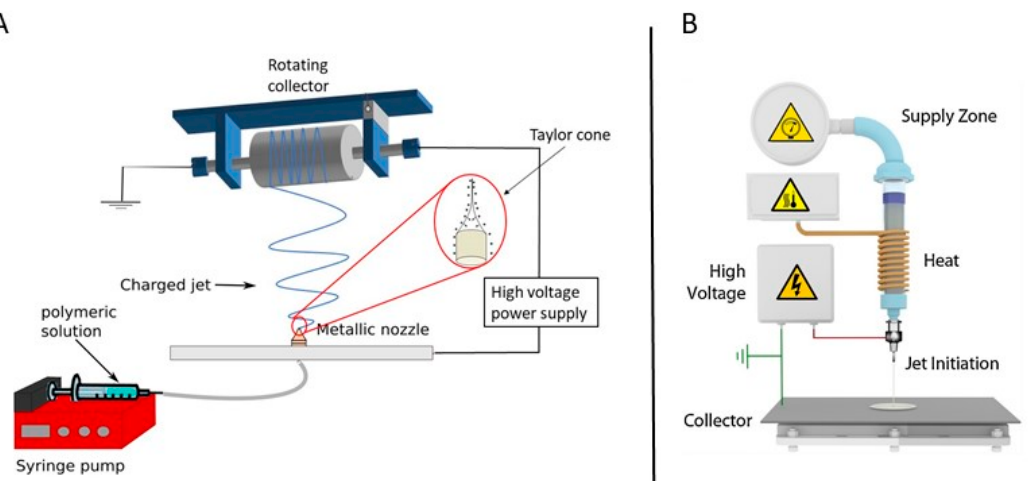
Figure 7. A schematic representation of ( A ) a polymer solution reproduced with permission from [106]. American chemical society, 2018 and ( B ) polymer melt electrospinning system—reproduced with permission from [107]. Copyright Elsevier, 2016.